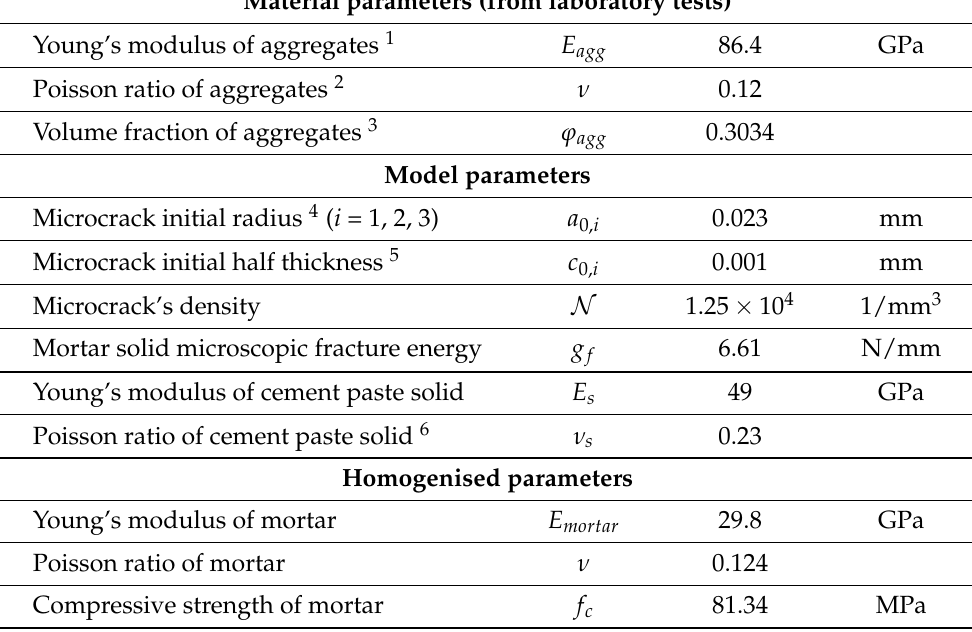
Table 5. Material parameters for the large quarzitic aggregates and the calibrated parameters for mortar, containing a volume fraction ϕ quartz = 30.34% of fine quarzitic aggregates. The mortar matrix is assumed to contain a 8.3% volume fraction of initial microcracks with an initial aspect ratio of 23. In the investigated concrete sample, the material properties of the mortar matrix with a volume fraction of ϕ quartz = 43.95% are determined by varying the volume fraction of aggregate accordingly in the Mori–Tanaka based homogenisation procedure, while keeping other parameters unchanged (group Model parameters ). The following sources are used to determine the parameters: